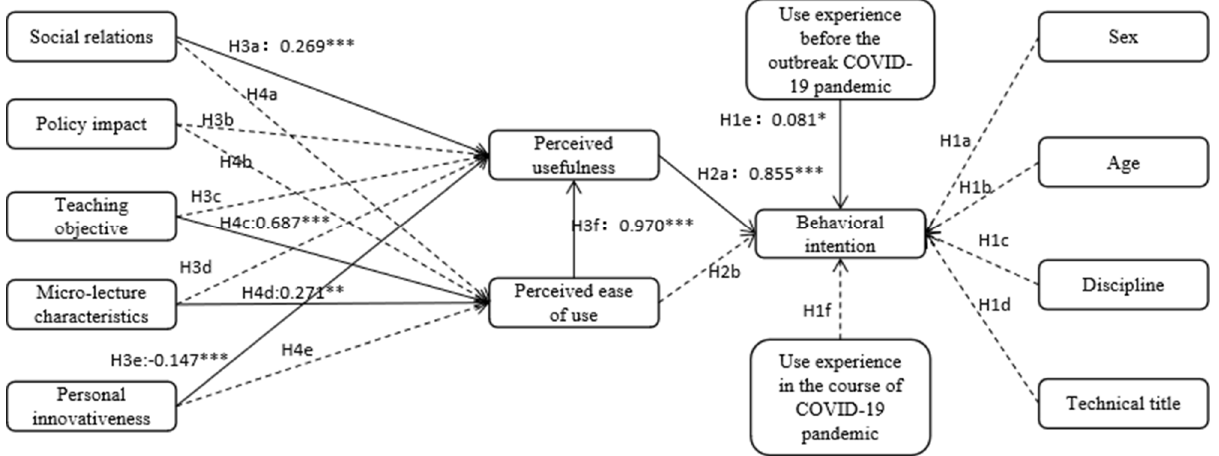
Figure 5. Validation of research hypotheses. (*: Significant at 0.1 level; **: Significant at 0.05 level; ***: Significant at 0.01 level). Table 12. Validation of path coefficient and research